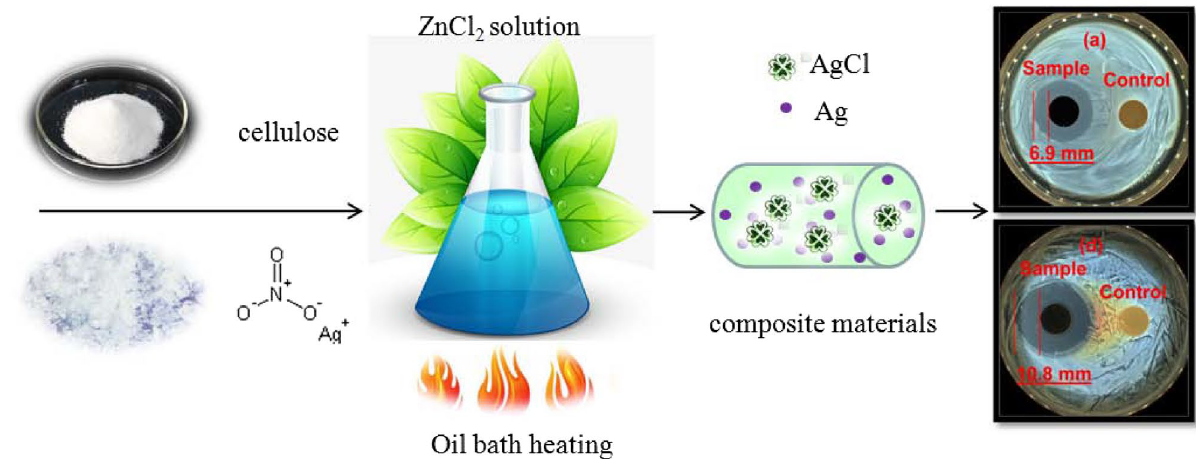
Figure 4. The schematic illustration of the formation process of Ag@AgCl-reinforced cellulose composites in the present strategy. (The illustration is drawn by